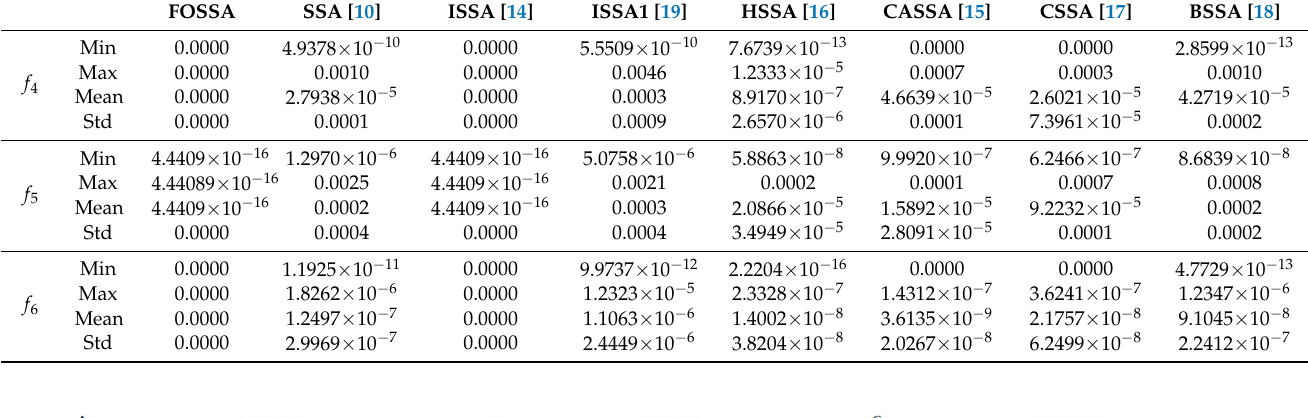
Table 3. Compared results of algorithms for multimodal functions.